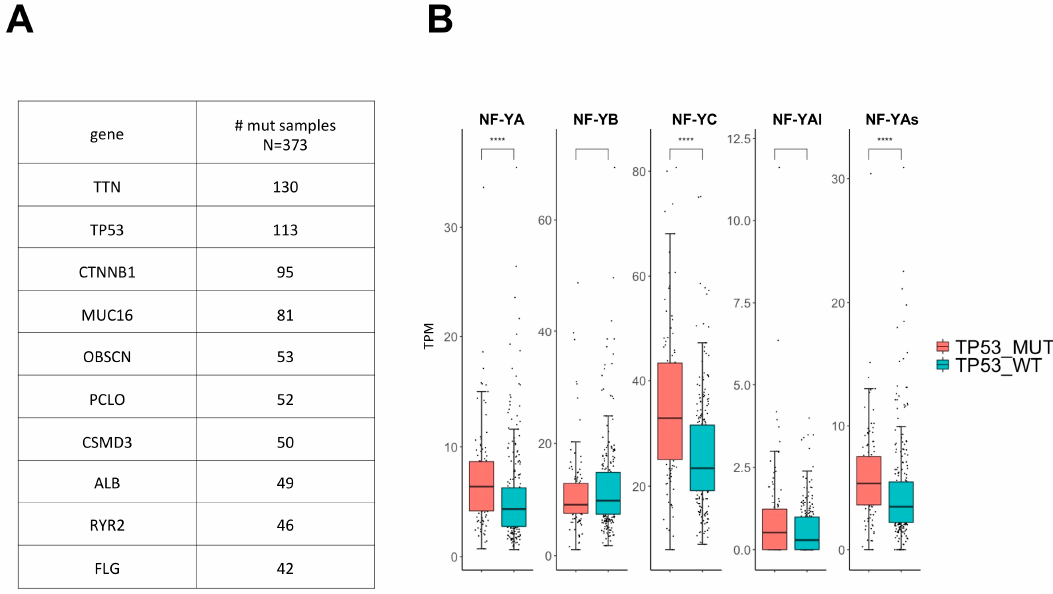
Figure 5. NF-Y subunits levels in HCC TP53 MUT . ( A ) Table with the top ten HCC mutations. ( B ) Box plot of NF-Y subunits and NF-YA isoforms mRNA levels in TP53 MUT compared with TP53 WT samples (p value: **** < 0.0001).